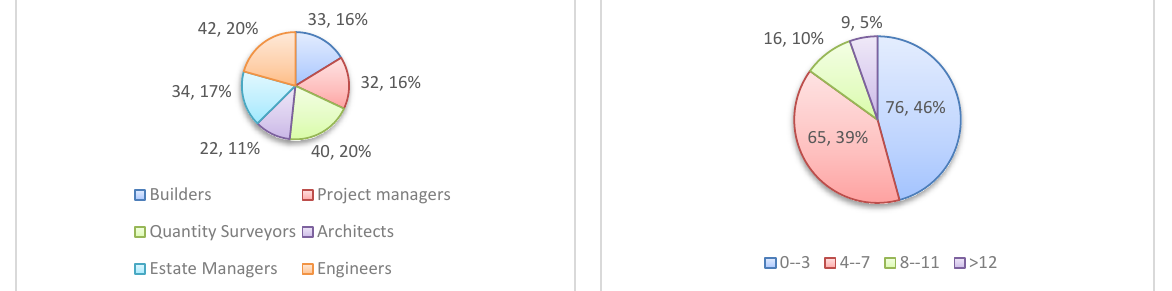
Fig. 3. Respondent’s profile